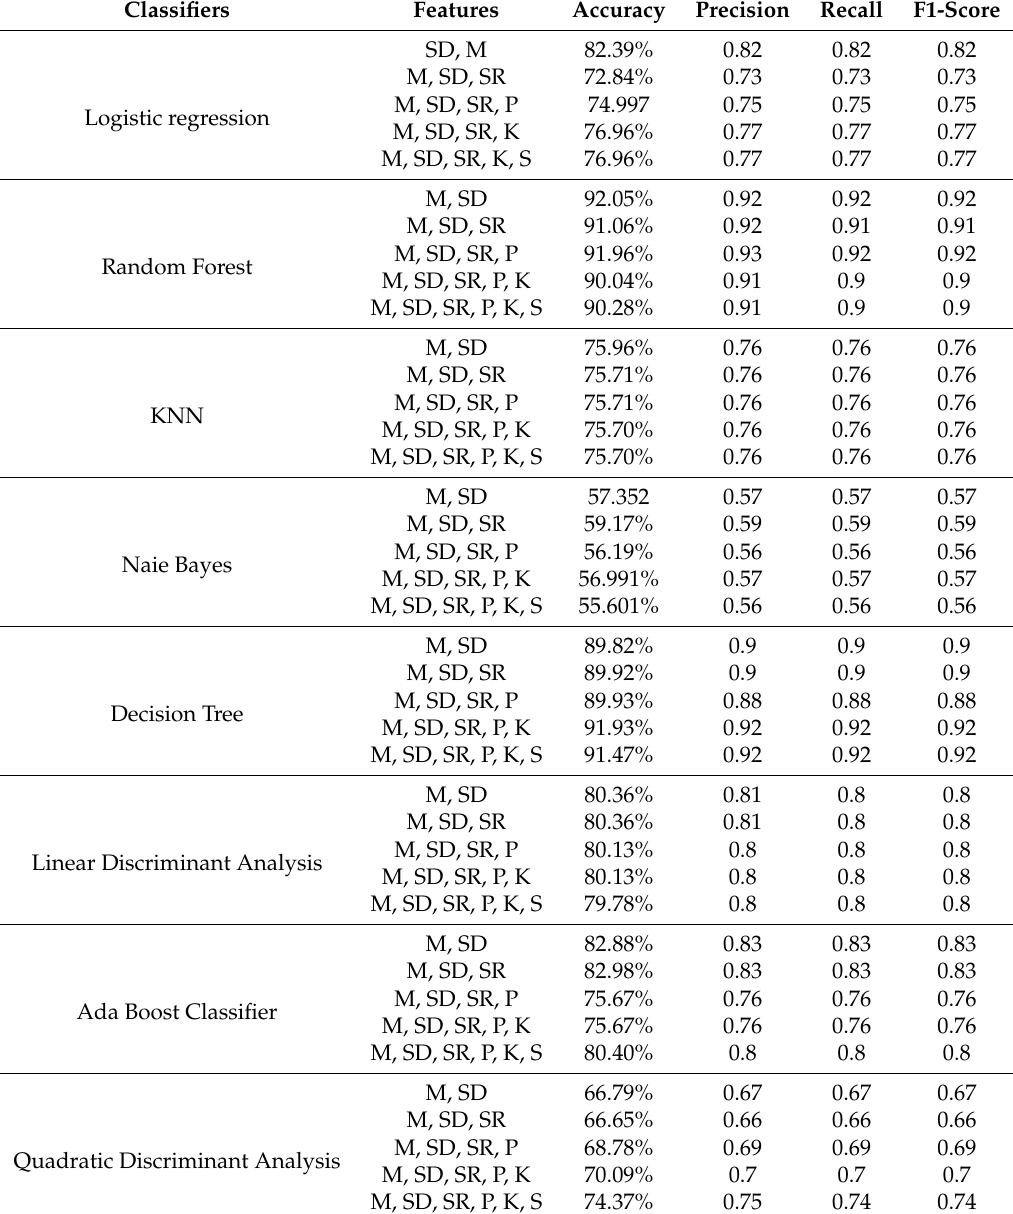
Table 4. Summary of ML results for combination features.